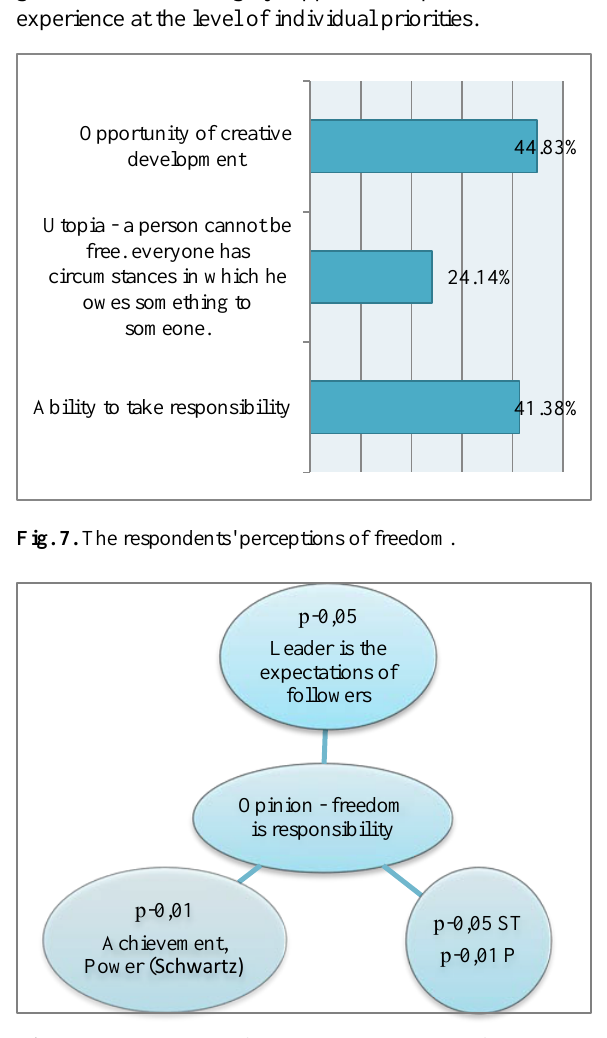
Fig. 8. Interconnection of respondents' ideas about freedom.